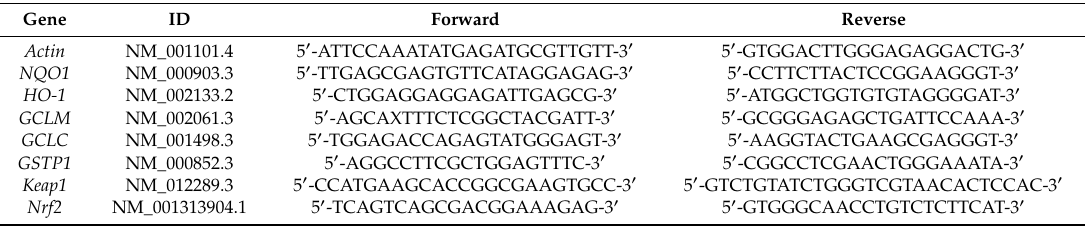
Table 3. Sequences of human primers